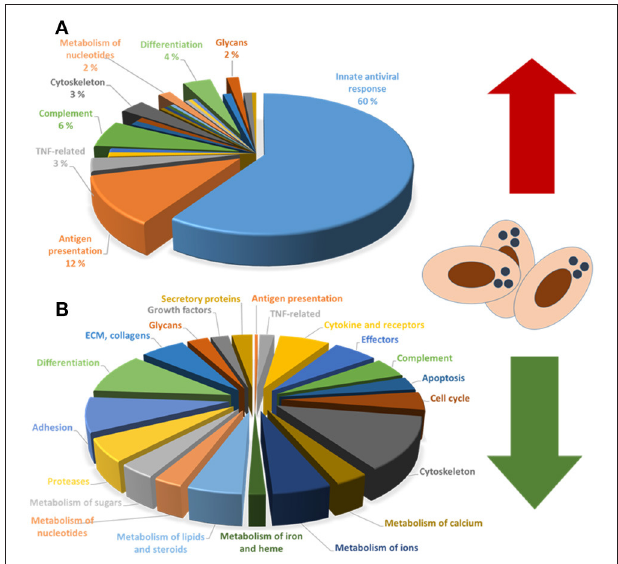
FIGURE 2 | (A) Upregulated and (B) downregulated functional groups of genes in PRV-infected red blood cells.